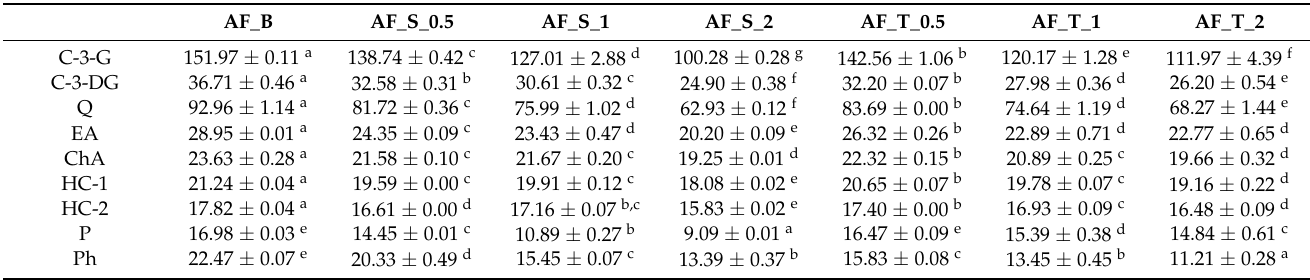
Table 3. Individual phenolic content (mg/100 g) in formulated